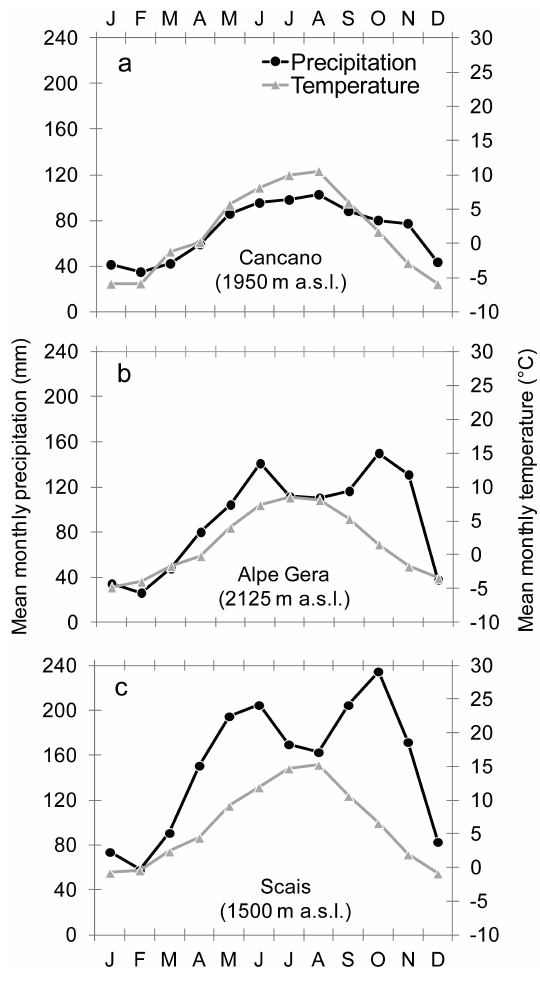
Figure 2. Climographs for the Cancano (Livigno sub-region), Alpe Gera (Disgrazia sub-region) and Scais (Orobie sub-region) weather stations. Time series: temperature (1990–2000); precip- itation (1951–2000 Cancano, 1990–2000 Alpe Gera, and 1958– 2000 Scais). Data sources: Servizio Idrografico e Mareografico Nazionale, Consorzio dell’Adda, ARPA Lombardia, Database OLL – Regione Lombardia